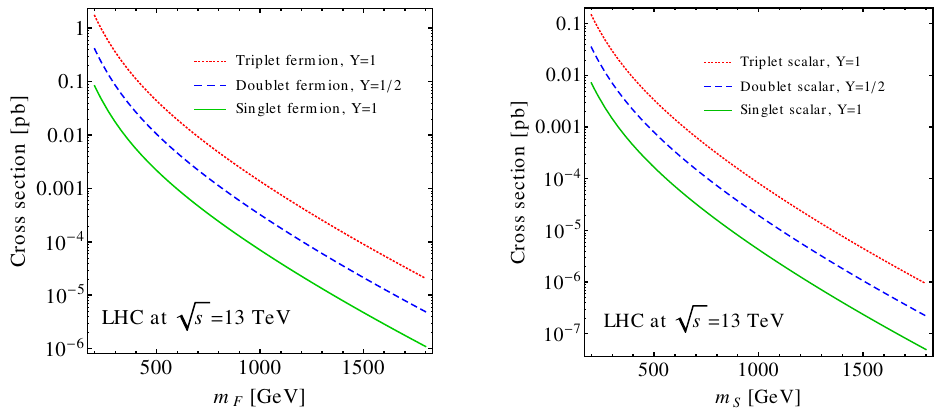
√ s = 13 TeV for the DY pair production representations: triplet (dotted L